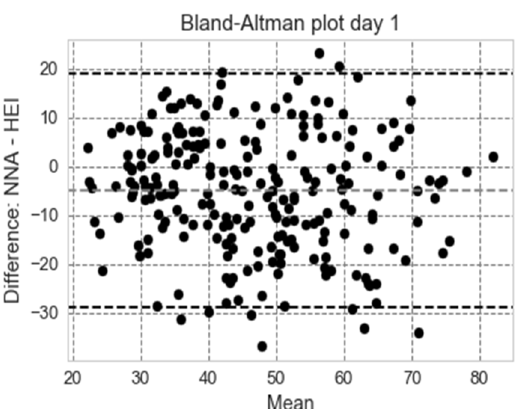
Figure 4. Bland–Altman plot showing agreement between HEI and the NNA score for women aged 31 – 50 years non-pregnant and non-lactating (NHANES 2011 – 2012, day 1, n = 155). NHANES: National Health and Nutrition Examination Survey, NNA: Nestlé Nutrition Algorithm, HEI: Healthy Eating Index.